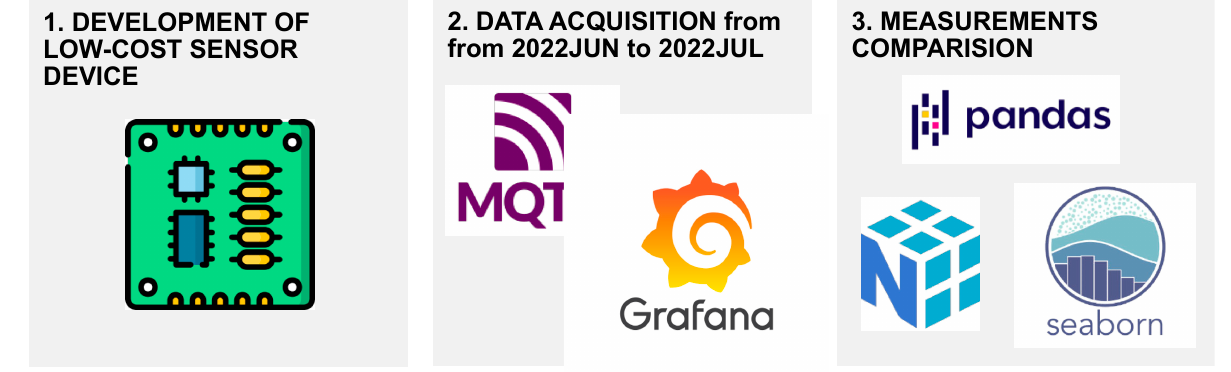
Figure 1. Workflow diagram.